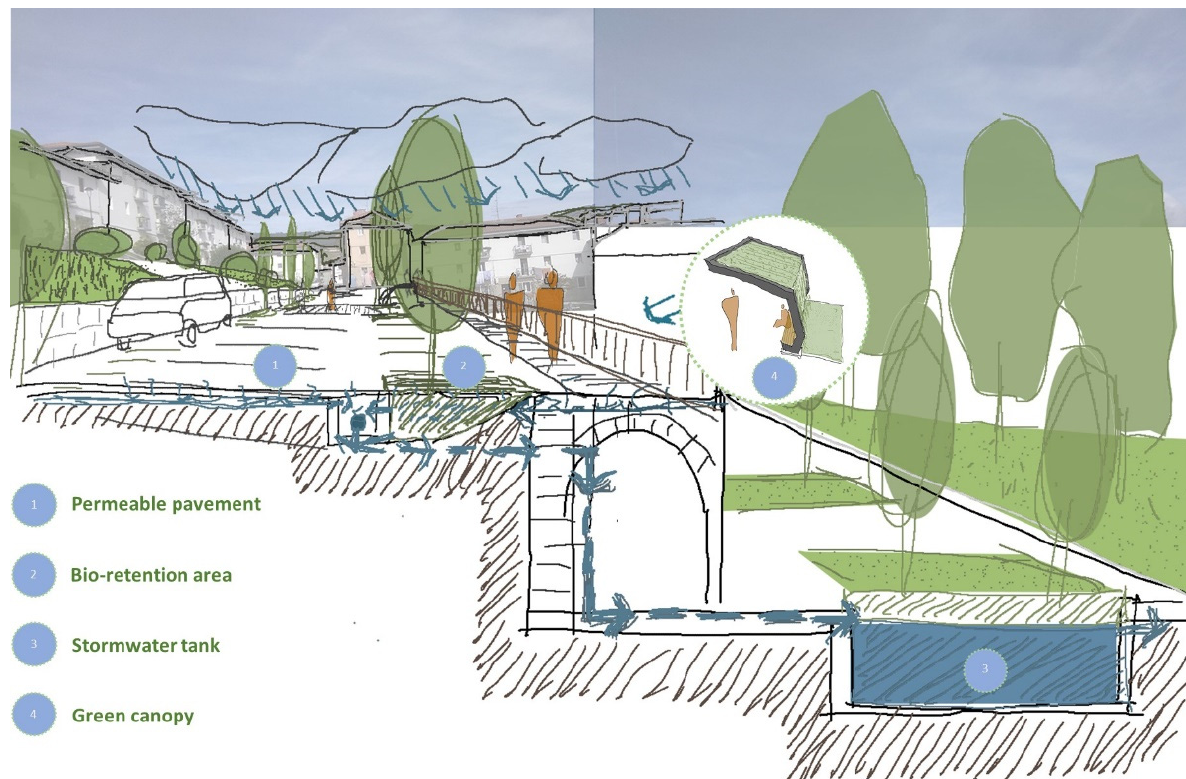
Figure 10. Scheme of the Legazpi’s green urban infrastructure project (developed by the authors).